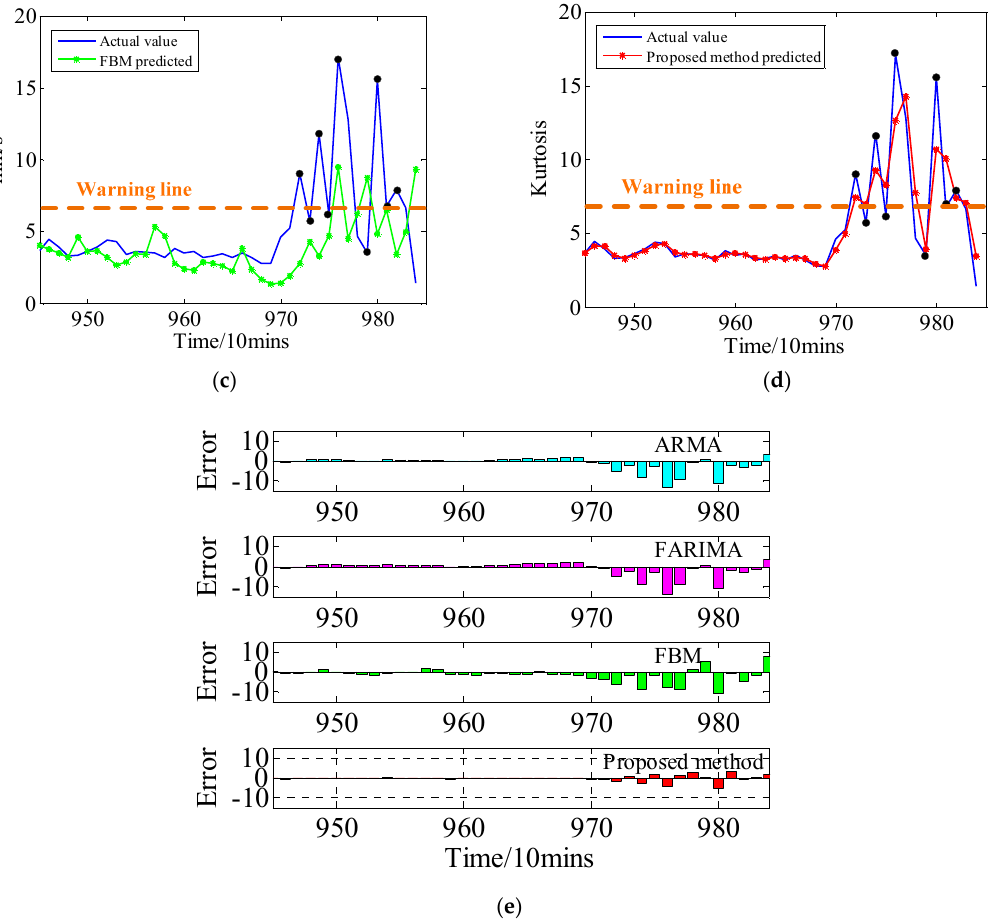
Figure 8. The kurtosis prediction results by the proposed method and the other state-of-the-art methods. ( a ) Prediction result using the ARMA model; ( b ) Prediction result using the f -ARIMA model; ( c ) Prediction result using the FBM model; ( d ) Prediction result using the proposed model; ( e ) Prognostic errors.